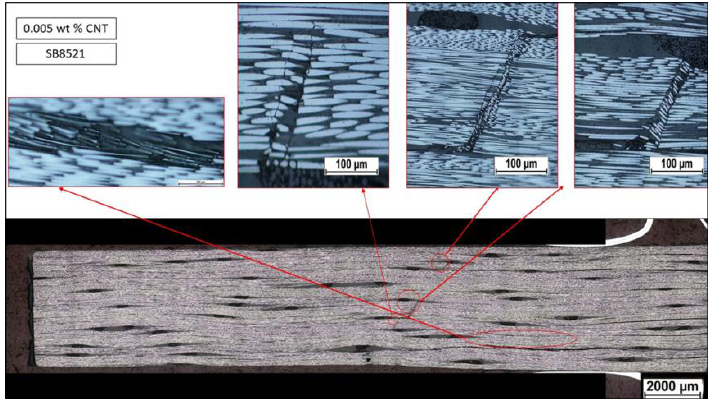
Figure 4. Micrograph of reference composite (composite reinforced with pristine CF fabric) short beam shear specimen after the test. The ( Bottom ) image shows an overview of the part of the specimen. ( Upper ) images indicate the fiber kinking that was formed during the failure.